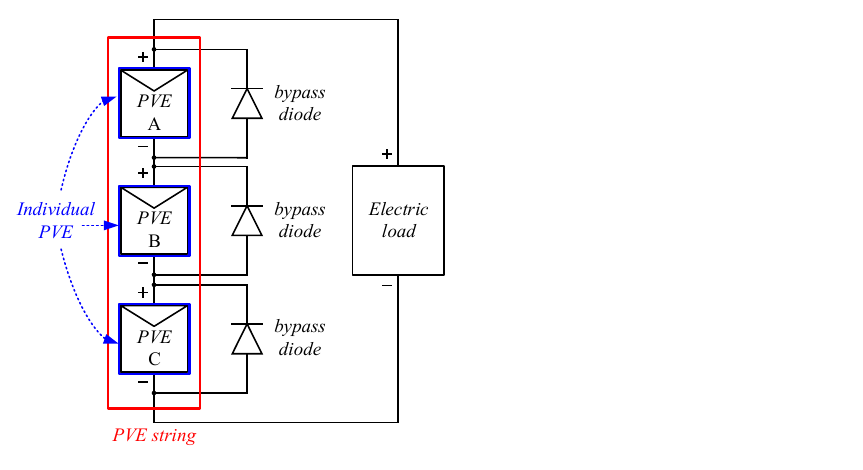
Figure 12. Configuration of the multiple series connections in the PVE for partial shading experiment.